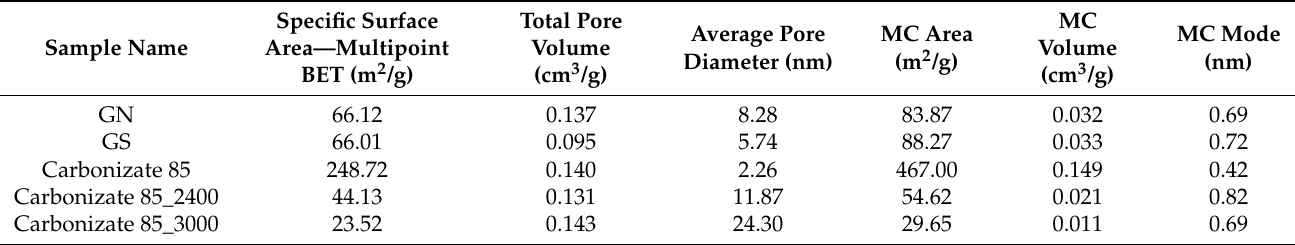
Table 2. Parameters of porous structure of samples determined on the basis of nitrogen sorption isotherm at 77 K and carbon dioxide sorption isotherm at 273 K (MC: Monte Carlo).